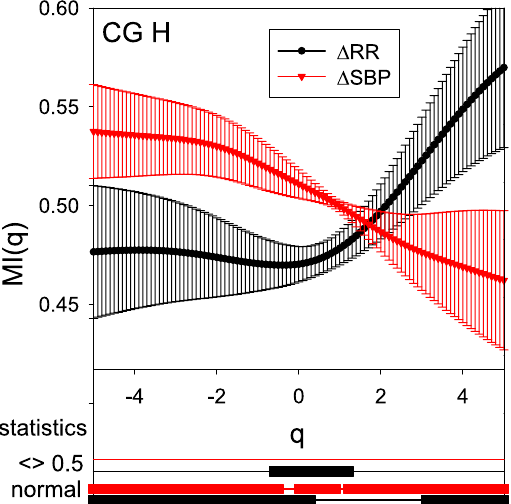
Figure 2. The mean MI q ( ) and MI q ( ) (with std errs) obtained from the signals of the CG group in the RR SBP supine position H. Below the q -axis, the statistics of the group results are given subsequently: bottom two lines mark q intervals in which the hypothesis of normality cannot be rejected (Lilliefors test, p < 0.05); top two lines mark q intervals in which MI s are distinct from 0.5 (two-sided t , p < 0.05). Black curves refer to RR data; red curves describe SBP